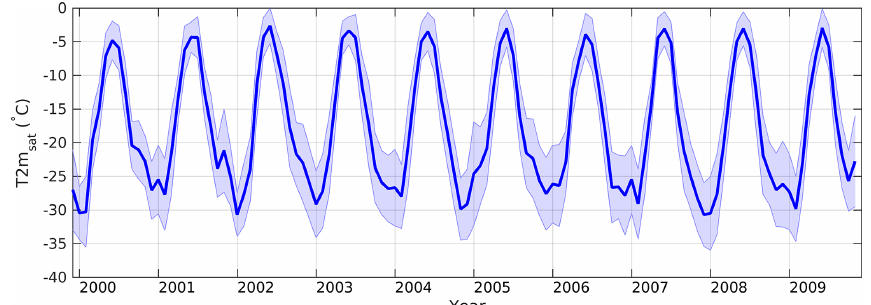
Figure 14. Monthly mean T2m sat for the Greenland Ice Sheet. The shading represents the variability.